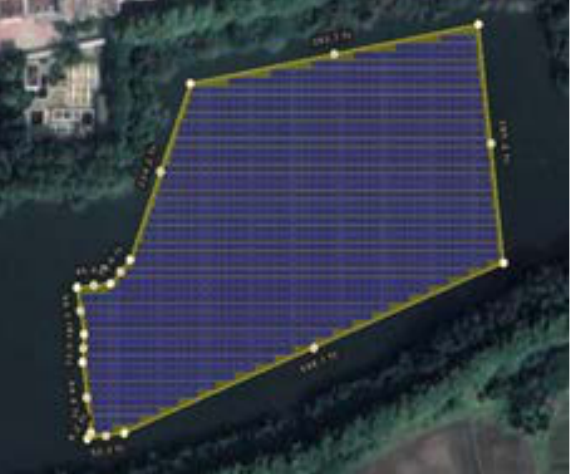
Figure 7. Layout of the PV site.